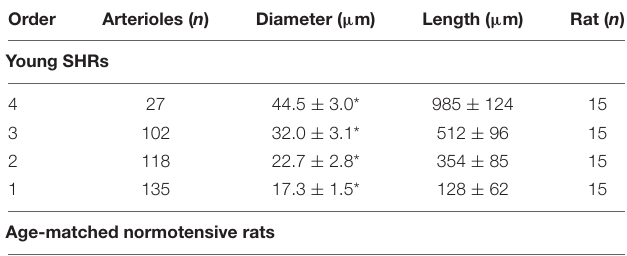
TABLE 1 | Classification of the pial arterioles in orders by Strahler’s method modified according to the diameters of young spontaneously hypertensive rats (SHR) and age-matched normotensive rats and of adult SHRs and age-matched normotensive